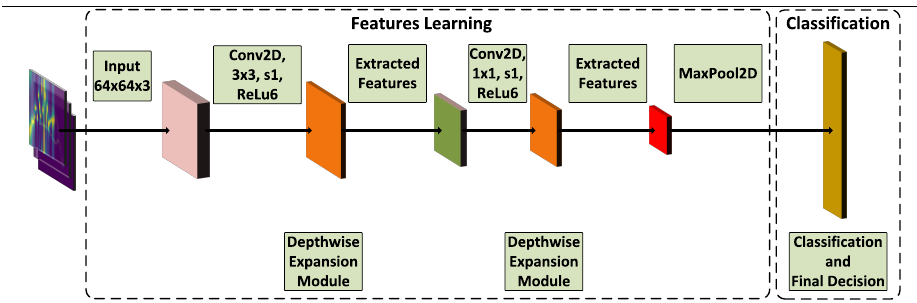
Figure 17. Proposed